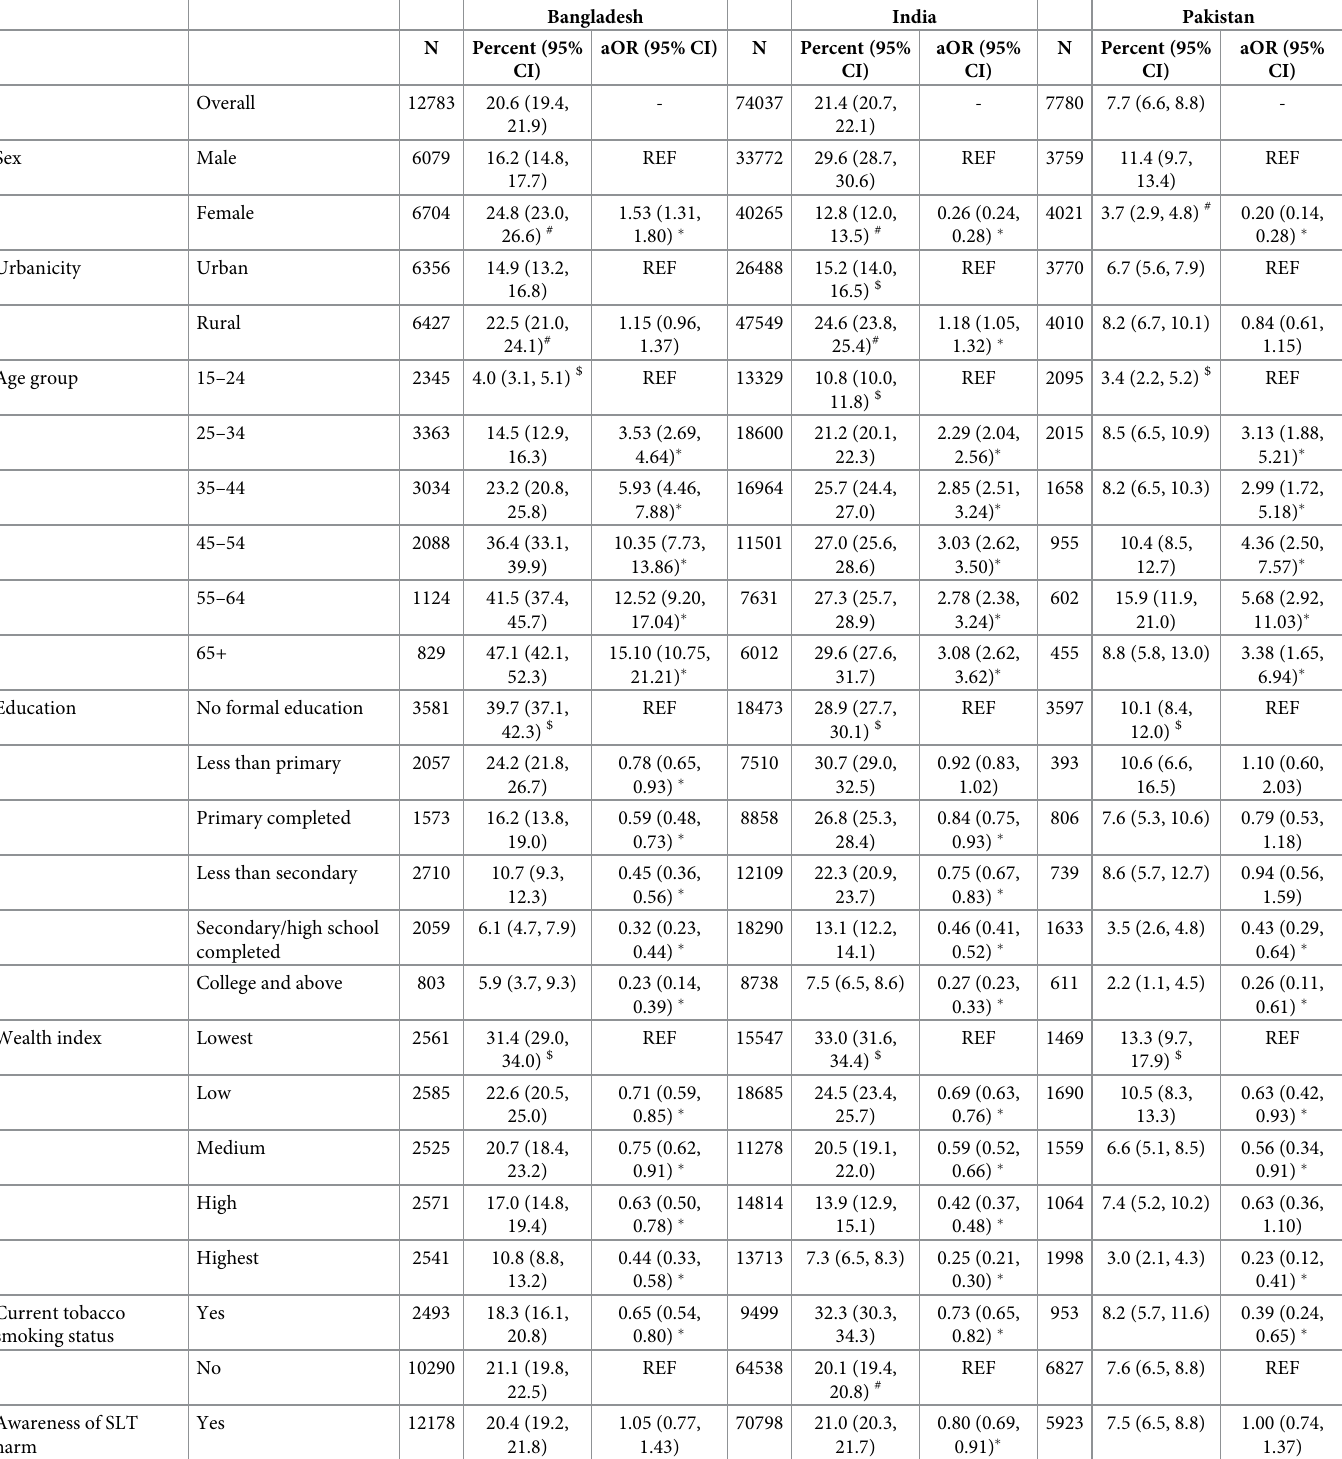
Table 3. Prevalence and adjusted odds ratios of current smokeless tobacco use among adults aged 15 years or older by selected demographic and socioeconomic characteristics in Bangladesh, India and Pakistan, GATS 2014–2017.